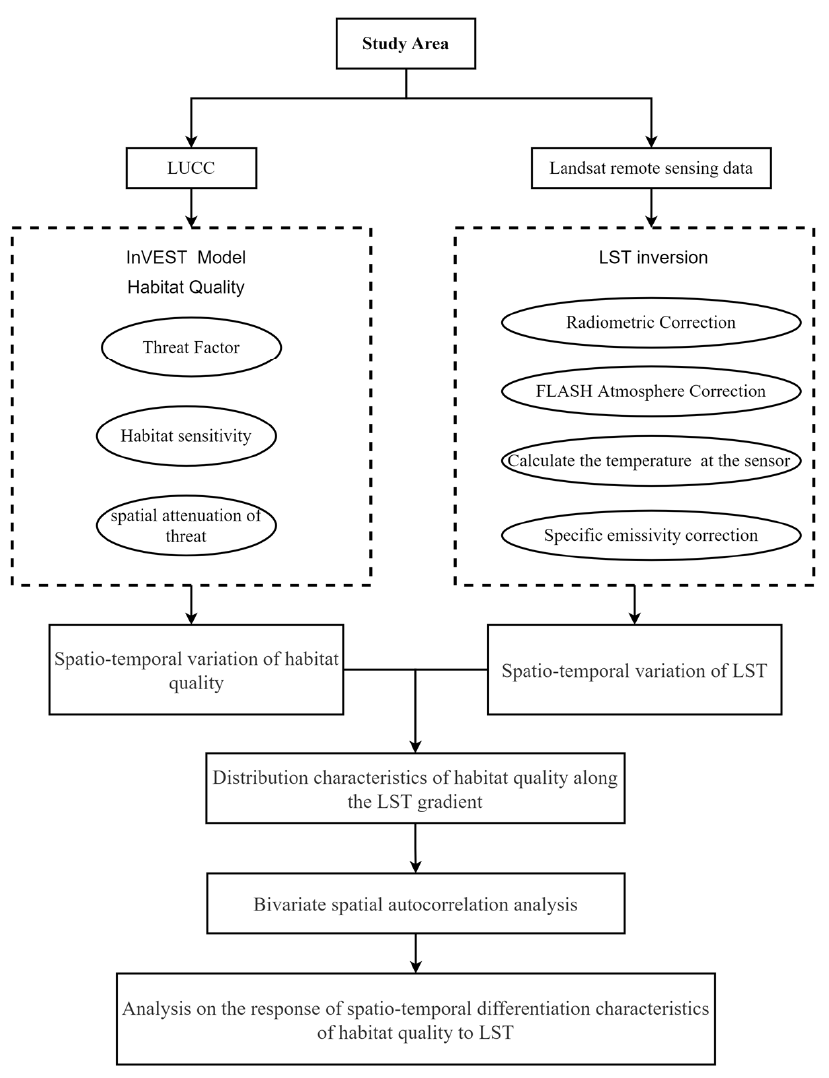
Figure 2. Workflow steps in our analysis.